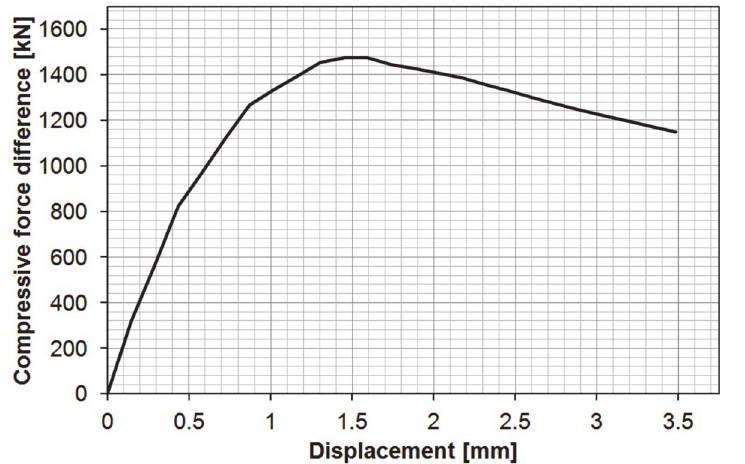
Figure 1: The experimentally-measured load-displacement